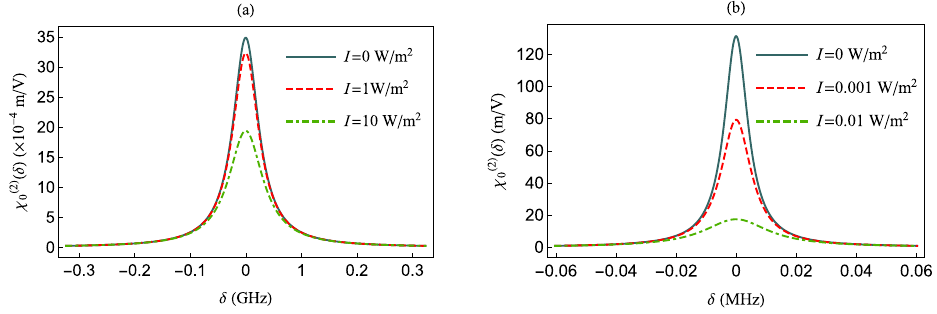
( 2 ) ( δ ) as function of δ for various intensities in the presence of the MNP and γ Figure 5. The χ 0 ( a ) The µ 12 is along the z -axis and d = 50 nm. ( b ) The µ 12 is along the x -axis and d = 34.5